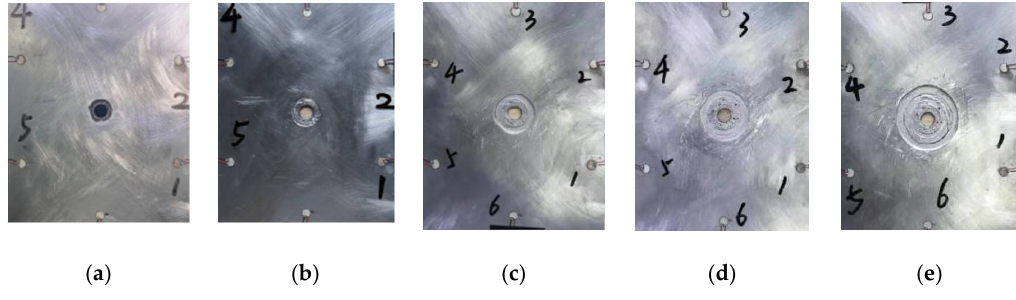
Figure 12. Five corrosion states, from ( a ) to ( e ). Table 5. Corrosion state and specific volume and time.